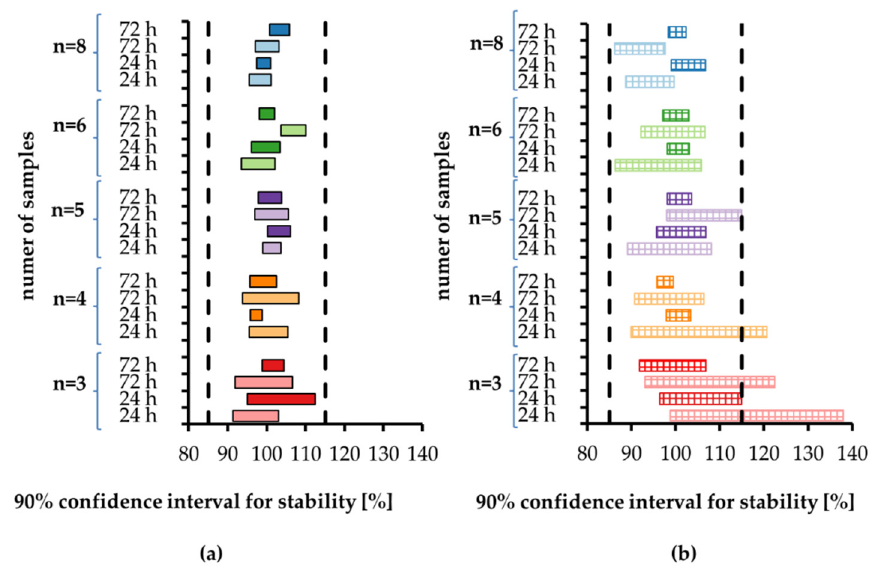
Figure 1. The 90% confidence intervals for the stability calculated according to [7] for ( a ) tramadol and ( b ) O-desmethyl-tramadol in human plasma stored at room temperature for 24 h and 72 h. Each sample size is associated with a different color, with light color indicating low concentration and dark color indicating high concentration. Vertical dashed lines indicate stability limits of 85–115%. Table 2. Descriptive statistics for the width [%] of a 90% confidence interval. The number of pairs is the equal number of reference and study